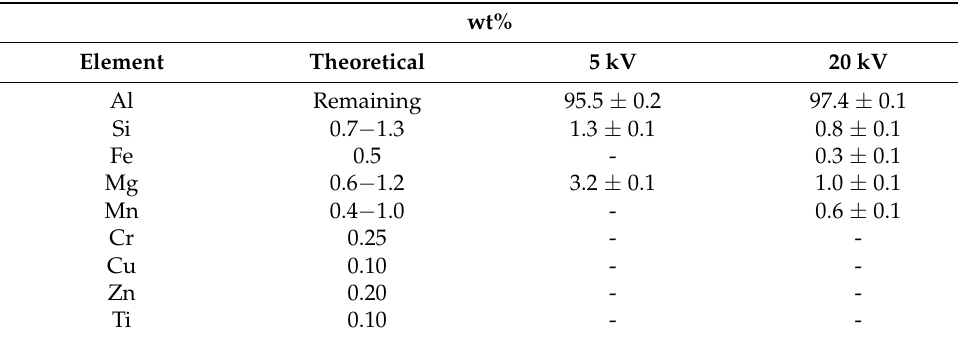
Table 1. Comparison between theoretical composition of Al6082, and the measured composition with EDS at 5 kV and 20 kV.